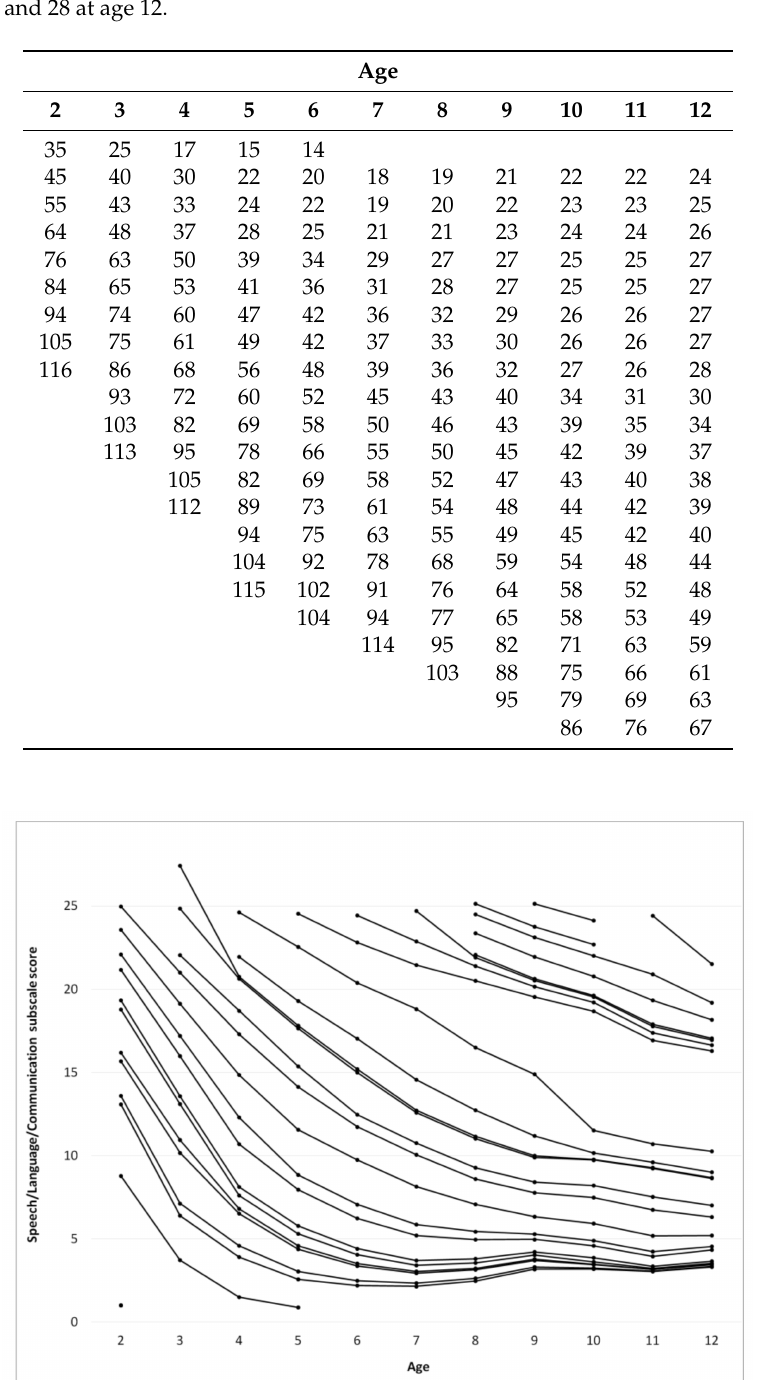
Table 1. The Total ATEC score norms as a function of the initial score and age from Figure 2. To find out a typical score trajectory for a child, (1) find the column with the child’s current age; (2) find the line with the child’s current ATEC total score; (3) in the same line, read typical ATEC total score at any age. For example, a typical child with ATEC total score of 116 at age 2 is expected to reduce ATEC total score to 86 at age 3; 68 at age 4; 56 at age 5; 48 at age 6; 39 at age 7; 36 at age 8; 32 at age 9; 27 at age 10; 26 at age 11; and 28 at age 12.